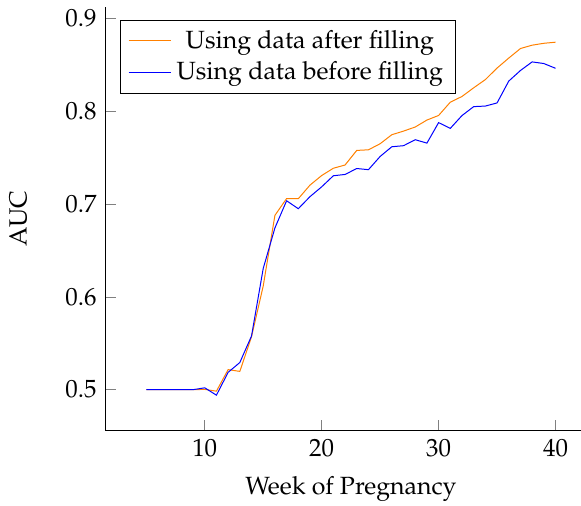
Figure 10. Prediction effect of different pregnancy